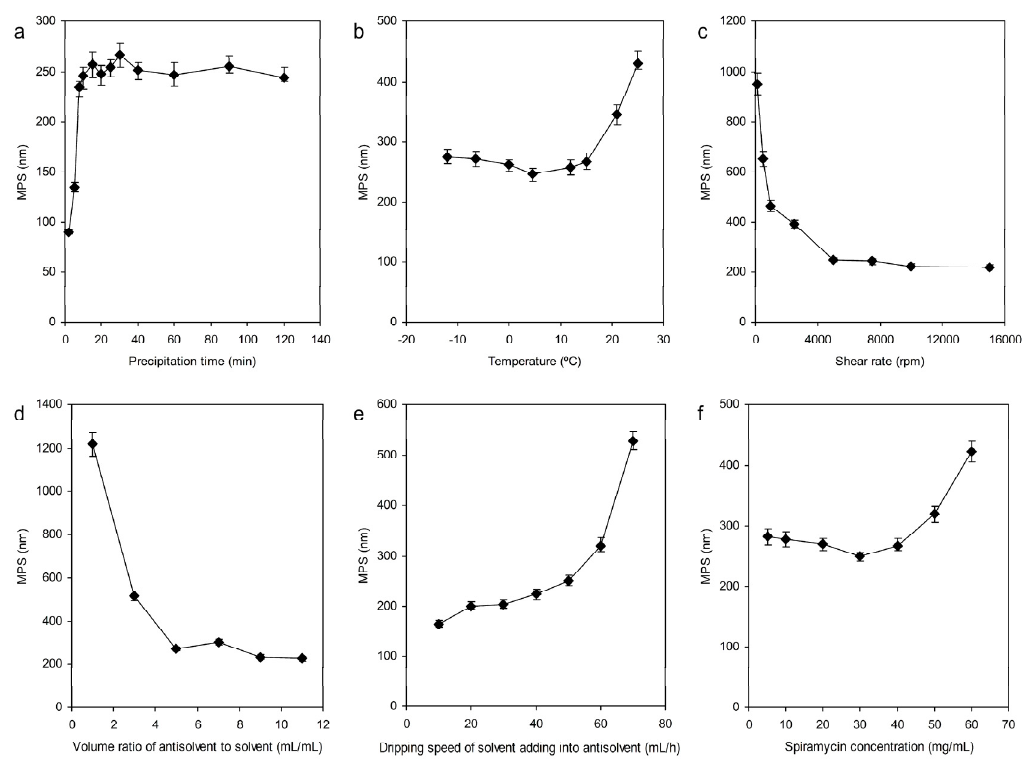
Figure 3. The effects of each parameter on the MPS of micronized spiramycin ( a ) precipitation time; ( b ) precipitation temperature; ( c ) shear rate; ( d ) volume ratio of the antisolvent to solvent; ( e ) dripping speed of the solvent adding into the antisolvent; and ( f ) spiramycin concentration. Each value represents means ± SD ( n =